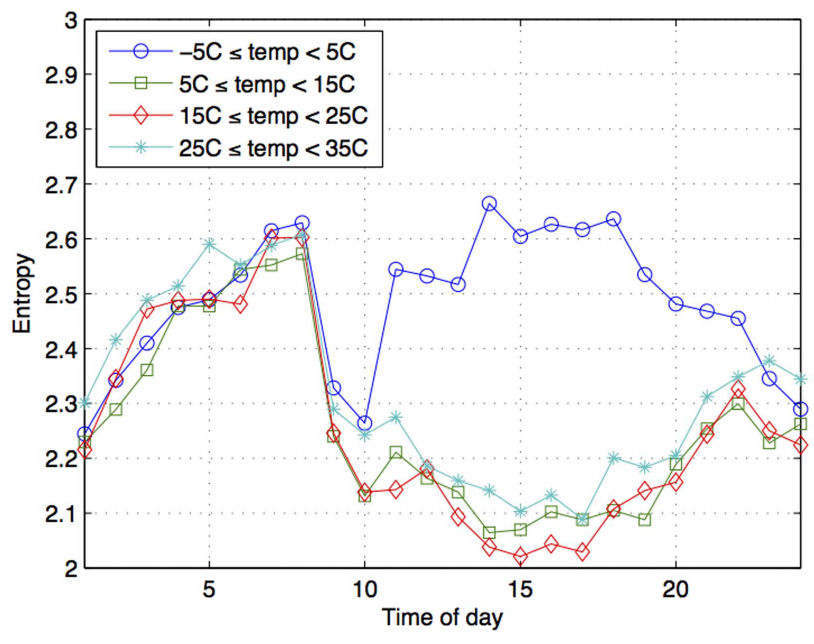
Figure 12. Entropy values across time of the day under different bands of temperature.